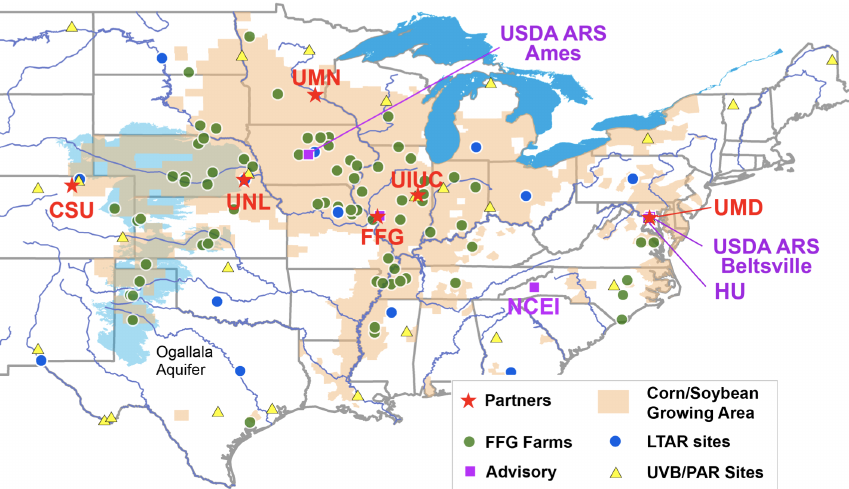
Figure 1. The geographic scope of the DAWN project, showing the 11 states chosen for the study focus (https://dawn.umd.edu/, last access: 28 February 2023). CSU is Colorado State University, UNL is the University of Nebraska–Lincoln, UMN is the University of Minnesota, FFG is the Family Farm Group, UIUC is the University of Illinois Urbana-Champaign, UMD is the University of Maryland, USDA ARS is the United States Department of Agriculture Agricultural Research Service, NCEI is the National Centers for Environmental Information, HU is Howard University, LTAR is Long-Term Agroecosystem Research, UVB is ultraviolet-B, and PAR is photosynthetically active radiation.